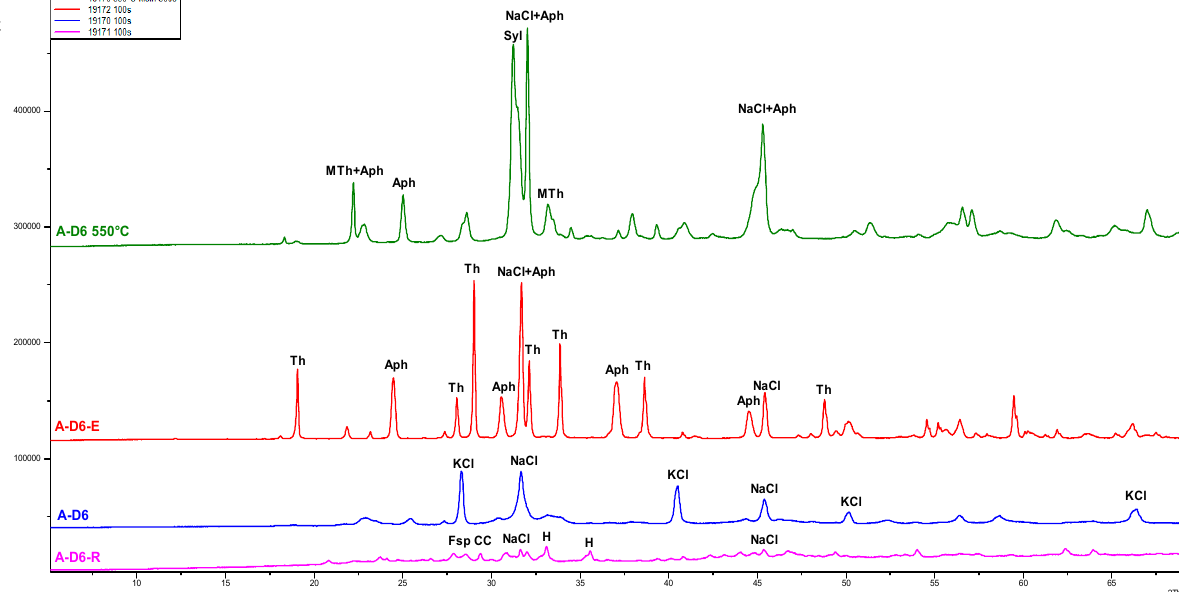
Figure 2. X-ray diffractograms of sample A-D6 after different treatments. Aph = Aphthitalite; Syl = Sylvin; Th = Thenardite; MTh = Metathenardite; Fsp = Feldspar; CC = Calcite; H = Hematite.